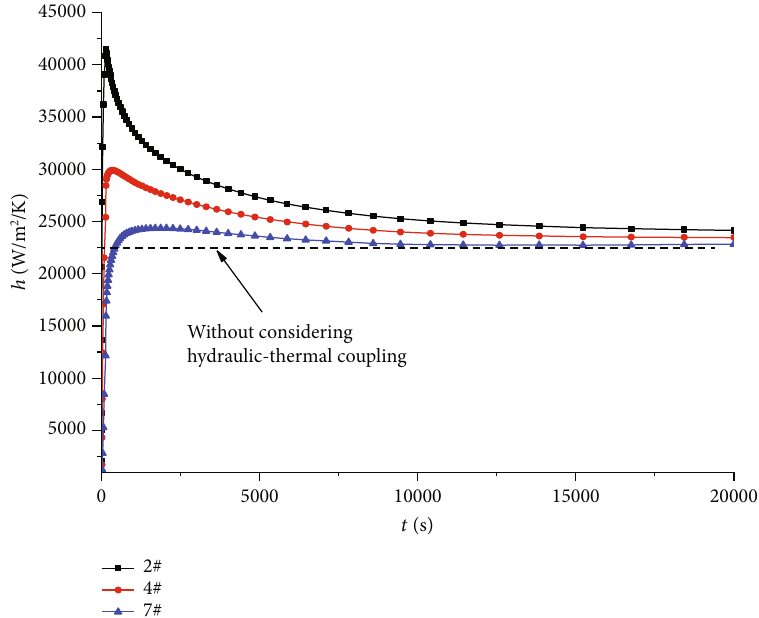
Figure 7: Heat conductivity h evolution of 2#, 4#, and 7# under the condition of hydraulic-thermal